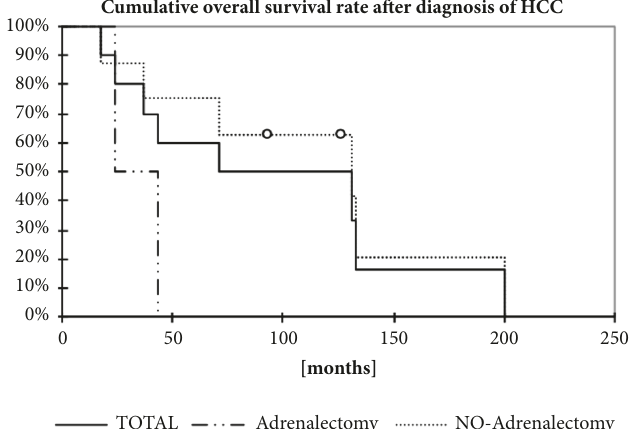
Figure 2: Display shows Kaplan-Meyer-Analysis of estimated overall survival after the diagnosis of adrenal metastasis depending on the treatment of the adrenal metastasis.